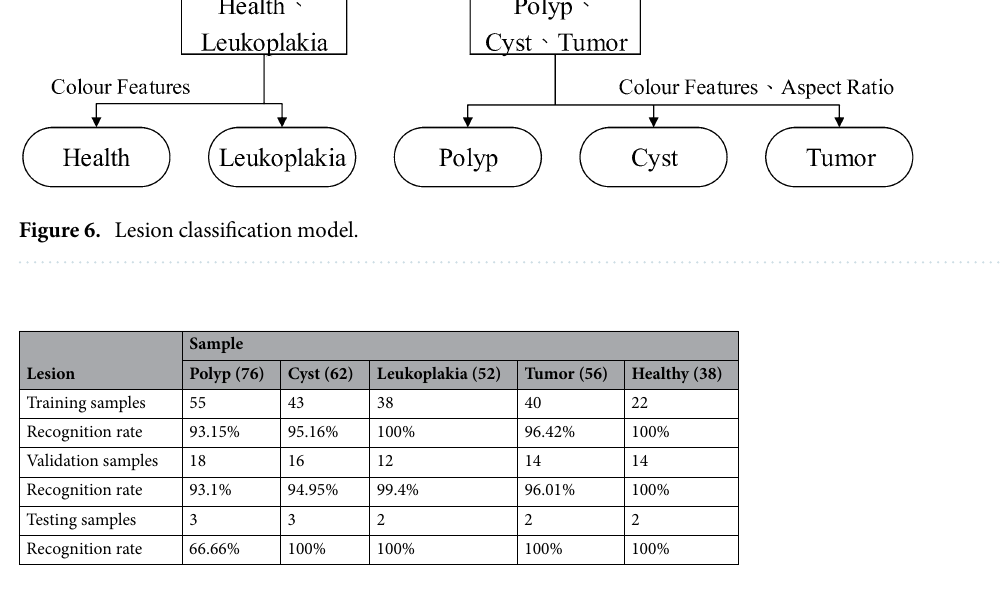
Table 2. Vocal cord lesion identification